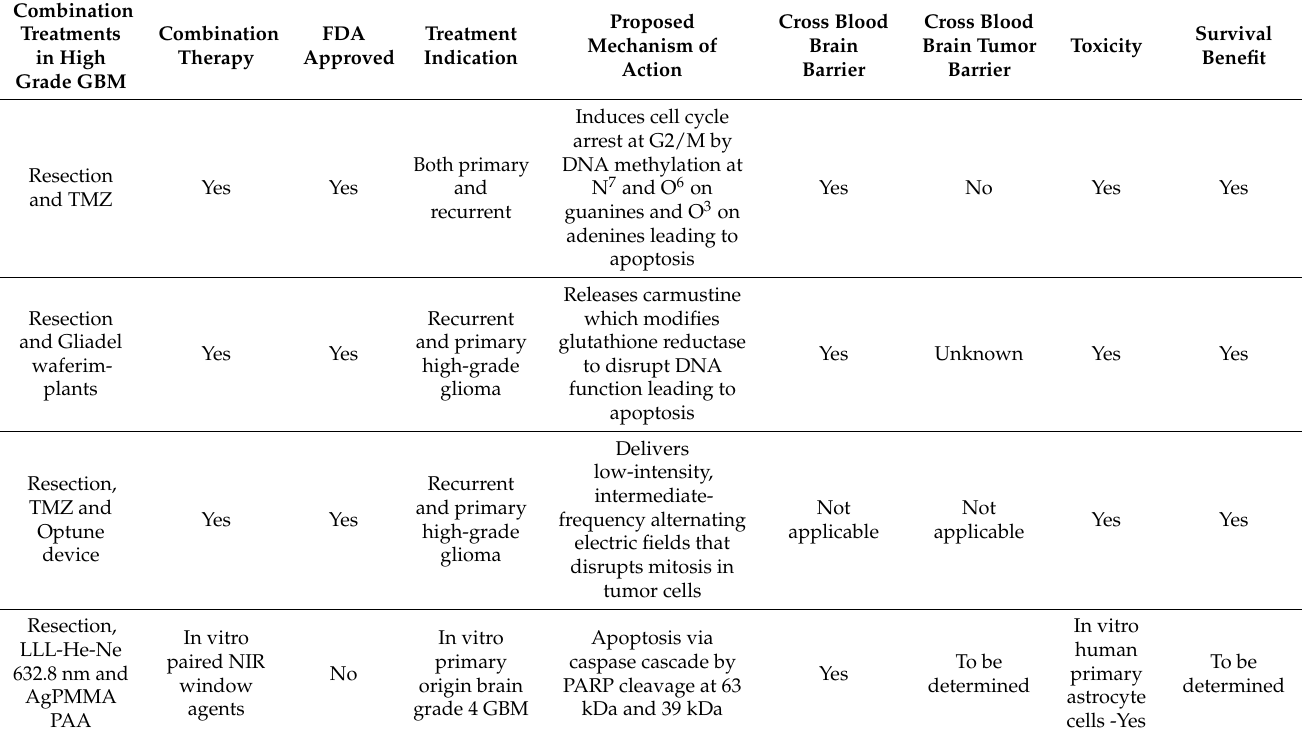
Table 1. Select combination treatments in high grade